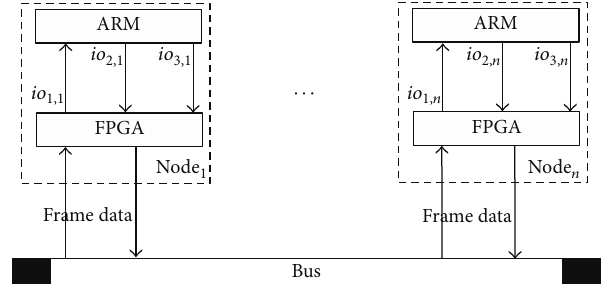
Figure 5: Representation of system.